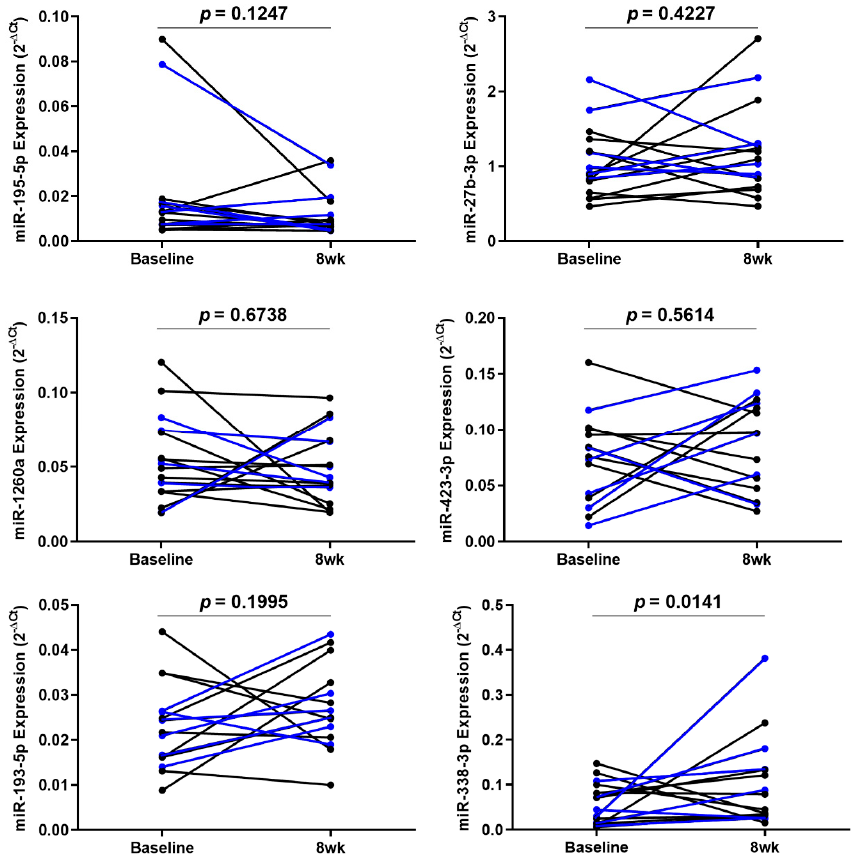
Figure 3. Individual variation of miR-195-5p, miR-27b-3p, miR-1260a, miR-423-3p, miR-193a-5p, and miR-338-3p after 8 weeks of treatment. Relative expressions of these miRNAs were validated by RT-qPCR in serum samples from 16 asth- matic patients treated with mepolizumab or reslizumab. Among these miRNAs, miR-338-3p was the only one that modi- fied its expression in a significant way. All experiments were performed in triplicate. Relative miRNA expression is ex- pressed as 2 −Δ Ct . Blue dots and lines represent patients treated with mepolizumab. Black dots and lines represent patients treated with reslizumab.